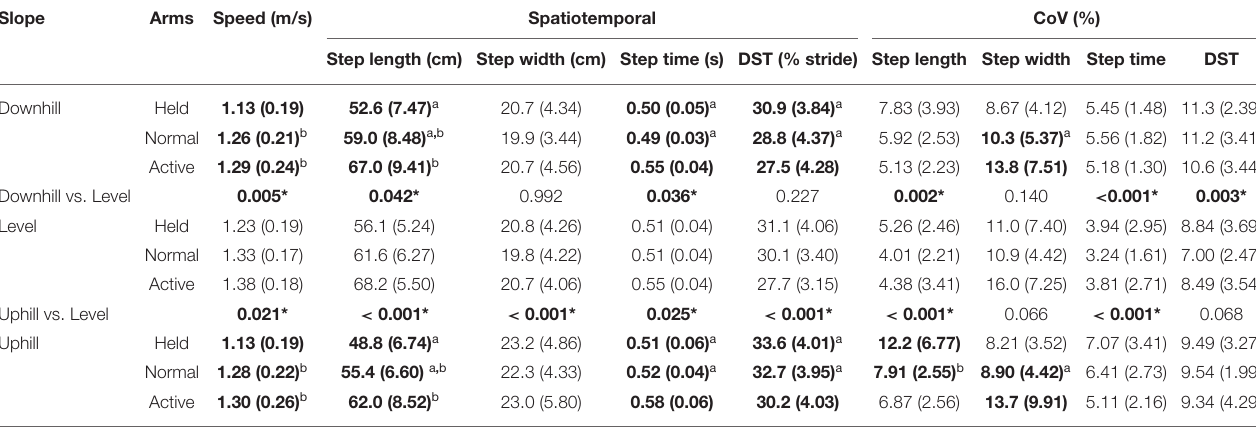
TABLE 3 | Comparison of speeds, spatiotemporal gait parameters, and coefficients of variation (CoV) in the three arm swing conditions (held, normal, active) during uphill, level, and downhill walking. Slope Arms Speed (m/s)